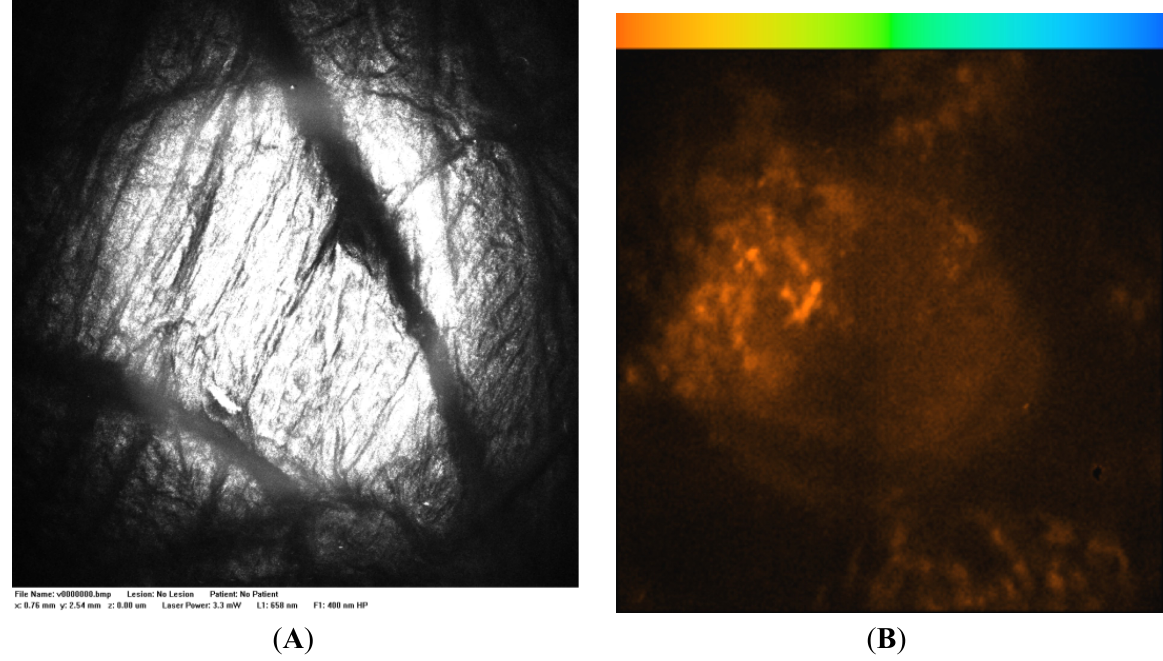
Figure 2. ( A ) Vivascope 658 nm reflectance image and ( B ) control fluorescence lifetime imaging (FLIM) image acquired 10 µm below the excised skin surface 3 h after application of phosphate buffered saline (PBS), magnification 400×; Field of view: 500 micron × 500 micron, FLIM color range 0–4 ns orange-blue.